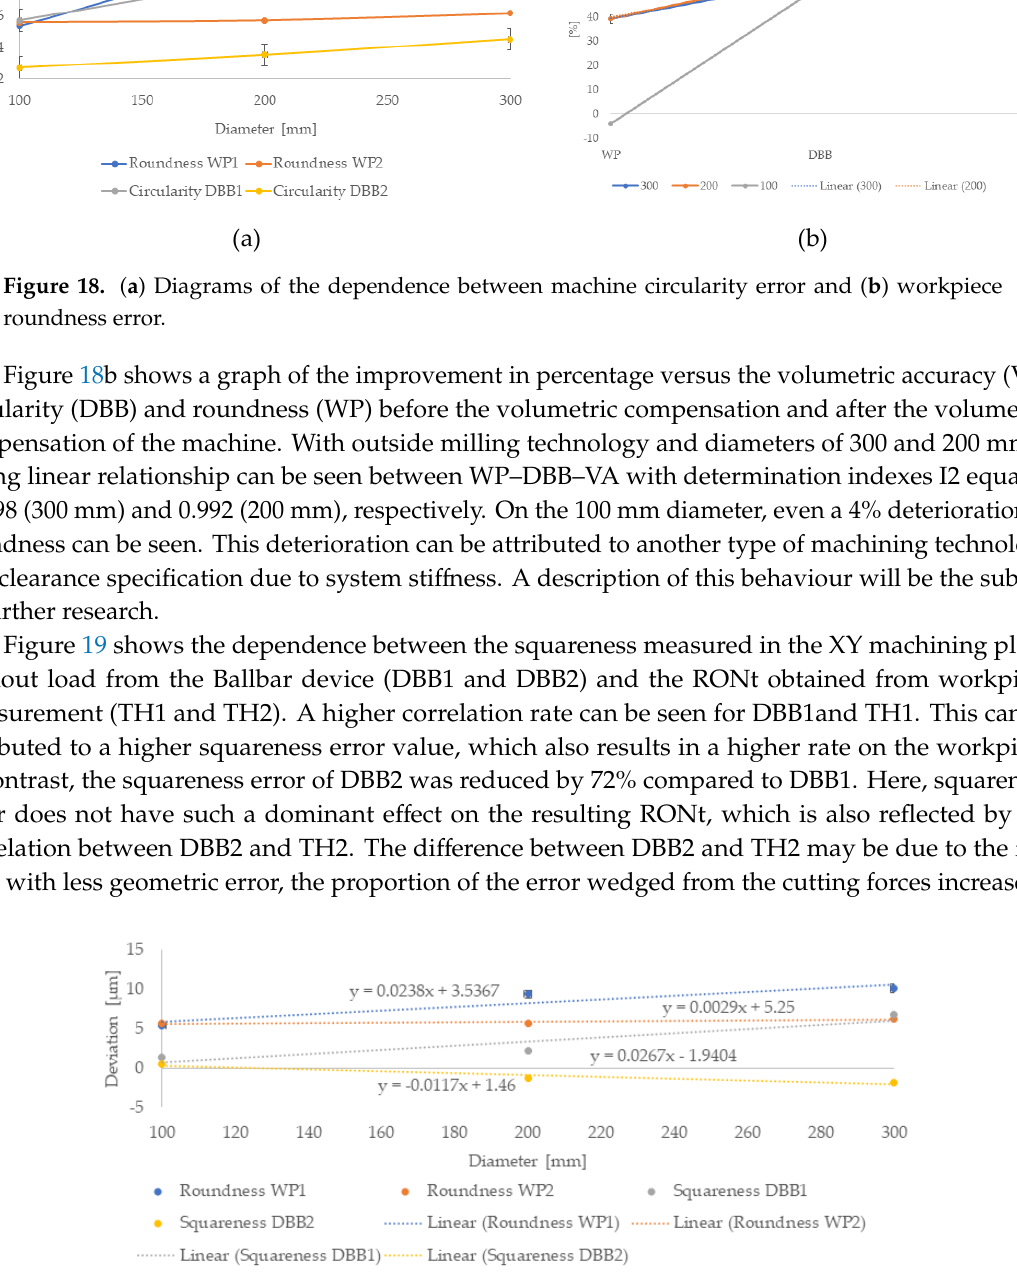
roundness error.